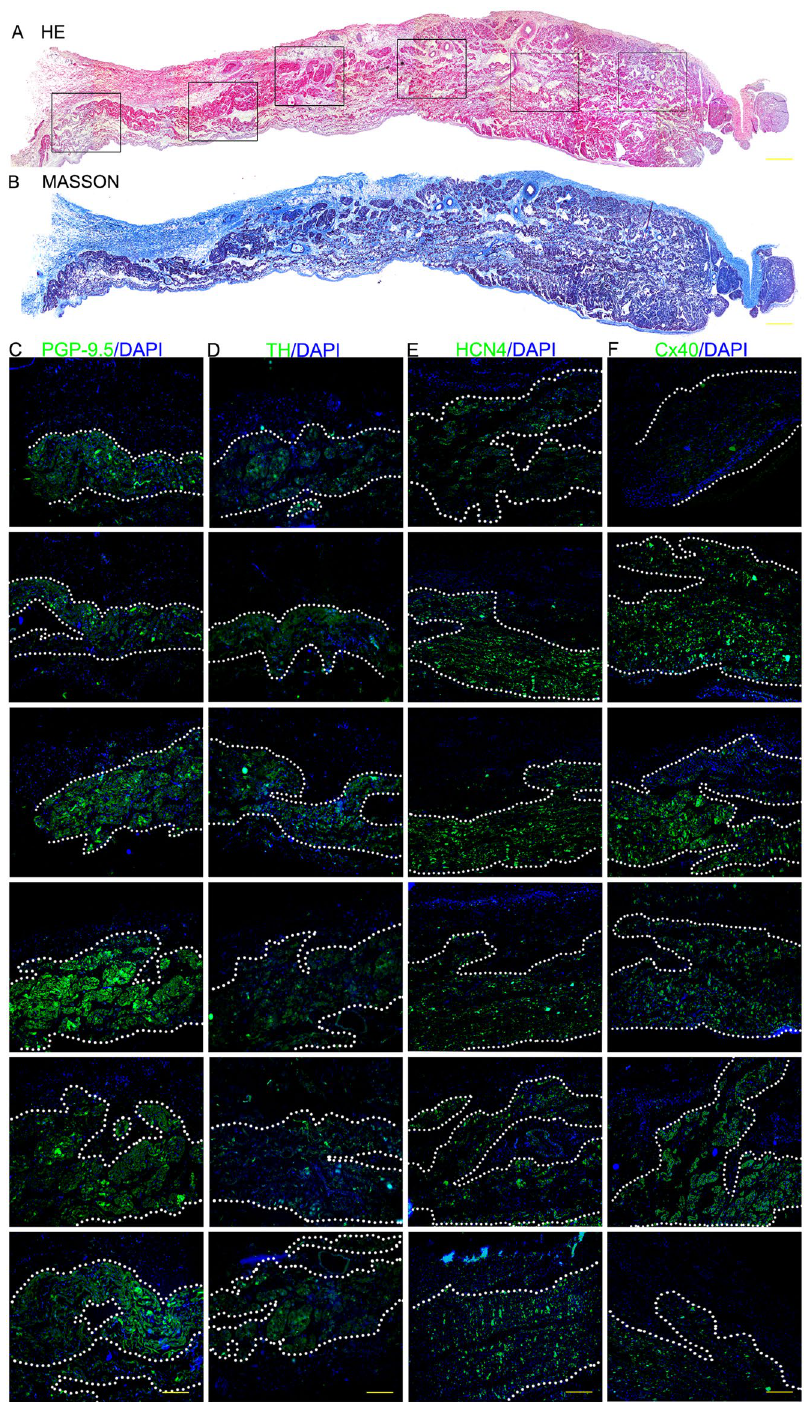
Figure 1. The results of the histological and immunofluorescence examination of the SAN. ( A) HE staining (scale bar = 1200 μ m). ( B ) Masson staining (scale bar = 1200 μ m). ( C ) Immunofluorescence staining with the anti-protein gene product 9.5 antibody (PGP9.5, the green region is the positive area). ( D ) Immunofluorescence staining with the anti-tyrosine hydroxylase antibody (TH, the green region is the positive area). ( E ) Immunofluorescence staining with the anti-connexin 40 antibody (Cx40, the green region is the positive area). ( F ) Immunofluorescence staining with the anti-hyperpolarization-activated cyclic nucleotide-gated channel 4 antibody (HCN4, the green region is the positive area). In C–F , cell nuclei are stained with DAPI, scale bar = 400 μ